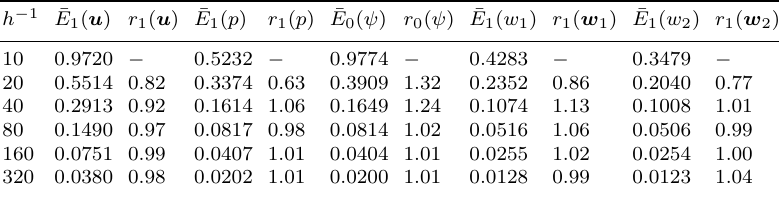
Table 1. Computed relative errors and their rate of convergence with mesh size h